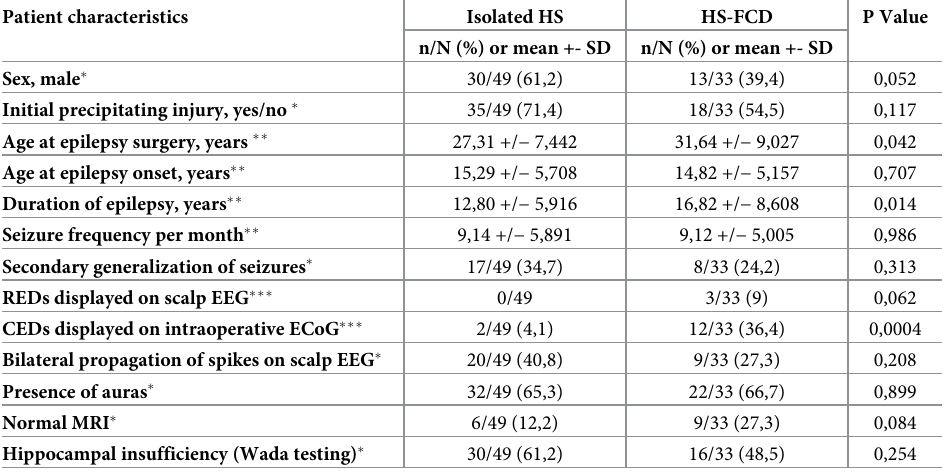
Table 1. Comparison of isolated HS and HS associated with FCD type 2 patients as to clinical